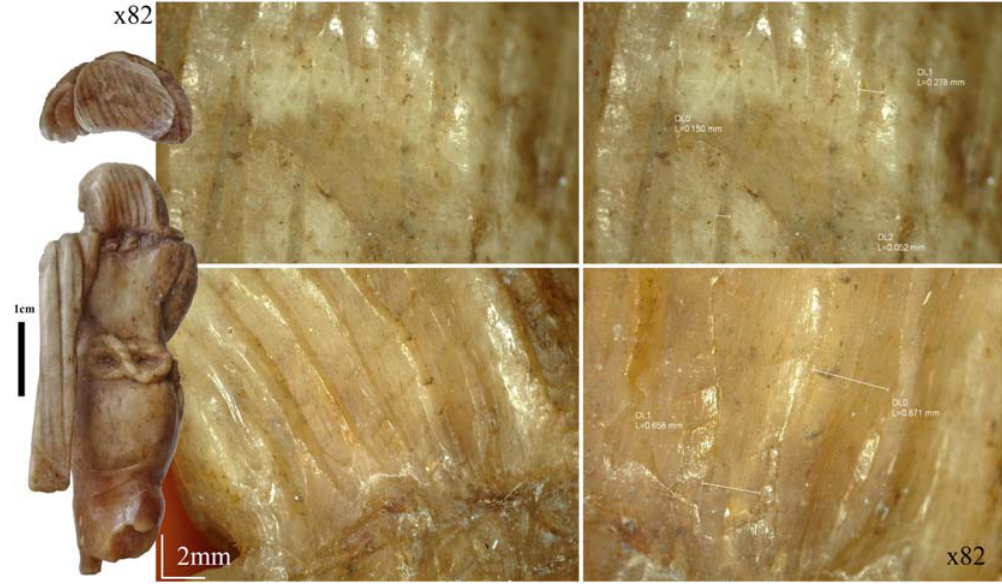
Figure 5: Posterior aspect of the hairstyle viewed from above and close to the shoulders ( bottom ) . Scale of the fi gurine, 1 cm ( Photo: Éva David )